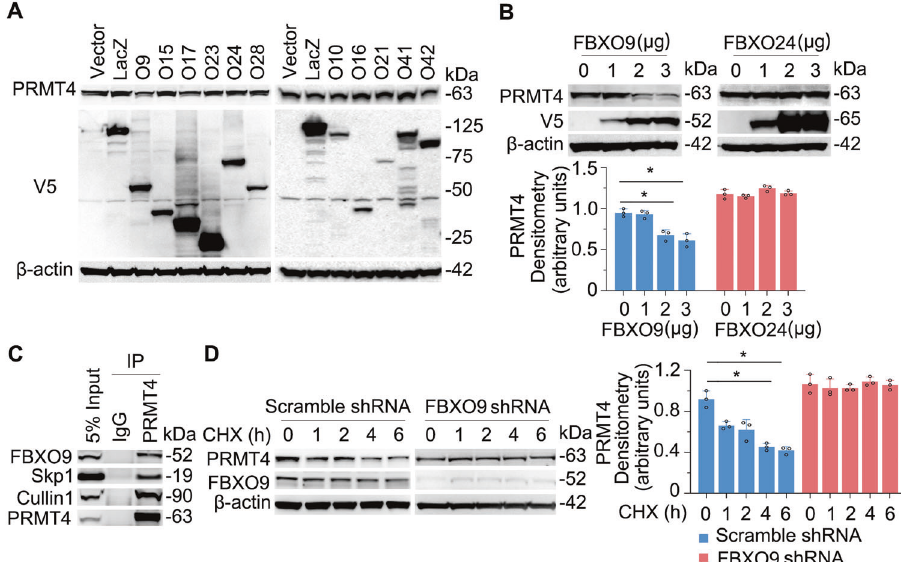
Fig. 3 SCF FBXO9 E3 ubiquitin ligase speci fi cally degrades PRMT4 in lung epithelia. A Screen of F-box (FBXO) family members revealed that overexpression of FBXO9 selectively degrades PRMT4 in BEAS-2B cells. B Ectopically expressed FBXO9 plasmid degrades PRMT4 in a concentration-dependent manner not observed with FBXO24 . Densitometric results are presented in the bottom panels. C Co-IP studies showing that PRMT4 interacts with Skp1 and Cullin 1, components of SCF E3 ligase. D Knockdown of FBXO9 stabilizes PRMT4 using protein half-life studies with cellular exposure to cycloheximide (CHX) for various times to inhibit protein synthesis. The relative expression of PRMT4 was plotted in the right panel. * P < 0.05 vs. time 0. Experiments n = 3.